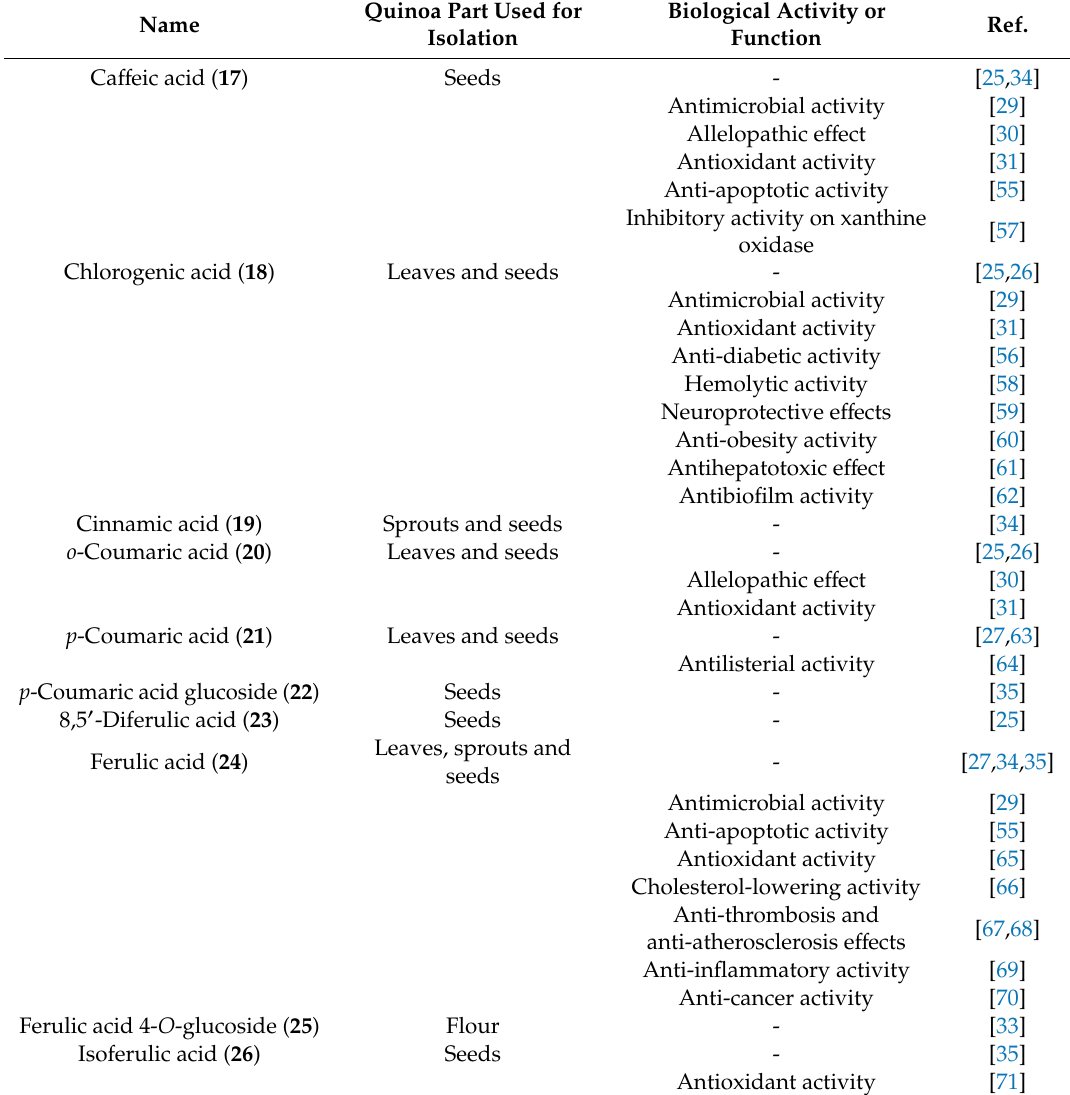
Table 2. Cinnamic acid analogues and their biological activities or